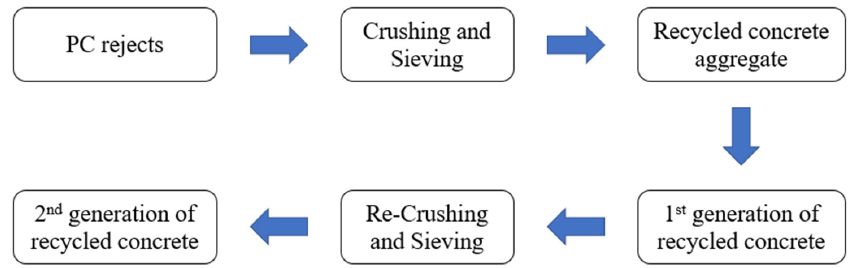
Figure 8. Evolution process of recycled PC